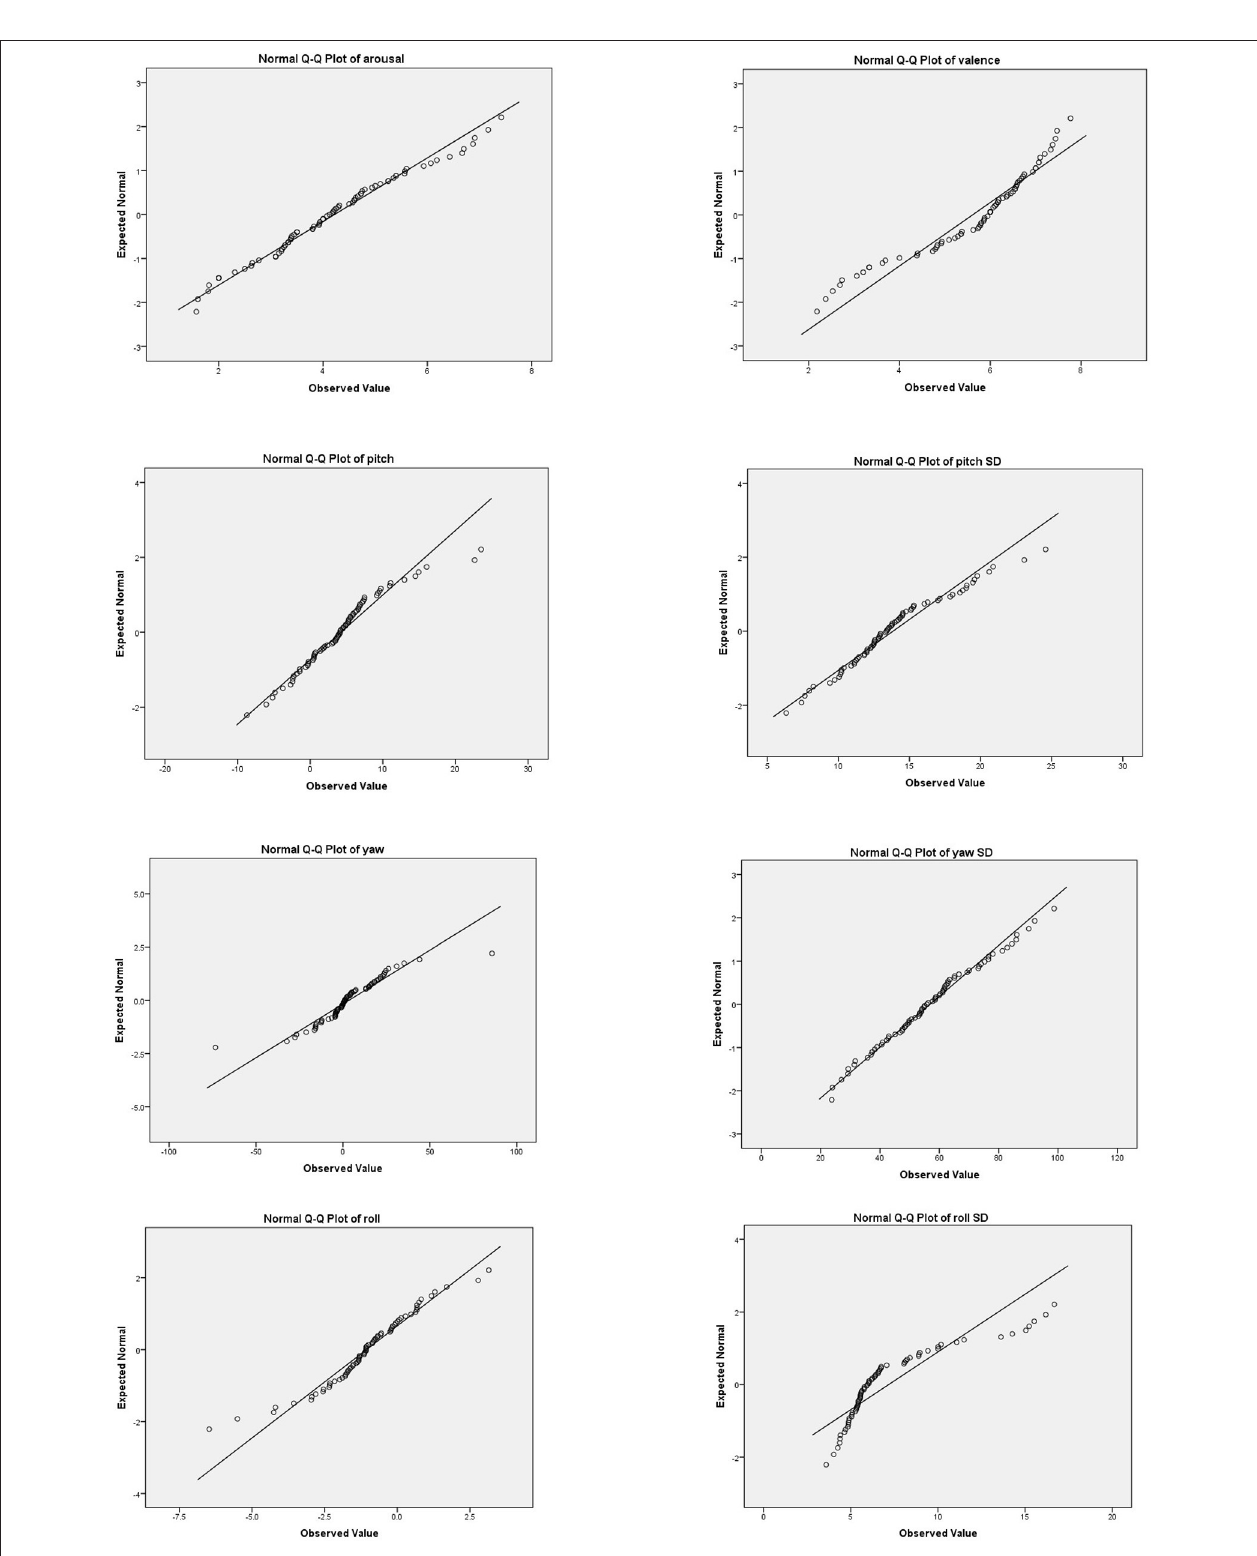
FIGURE 5 | Normal Q-Q plots of all observed